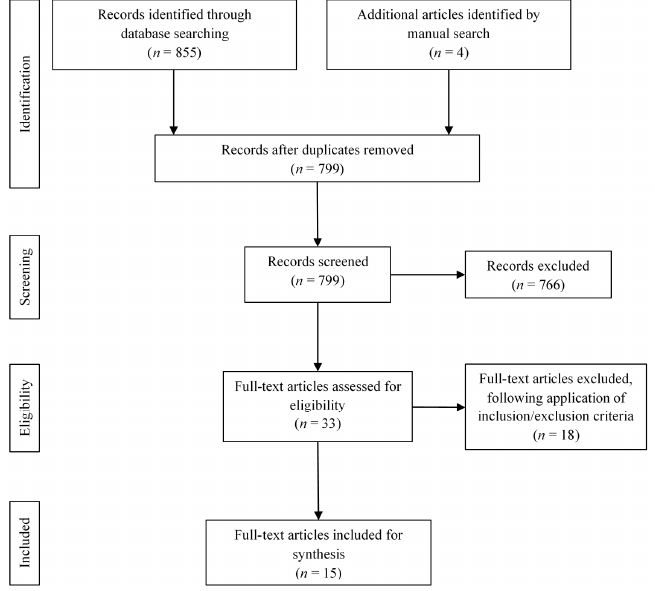
Figure 1. Identification and selection of studies.